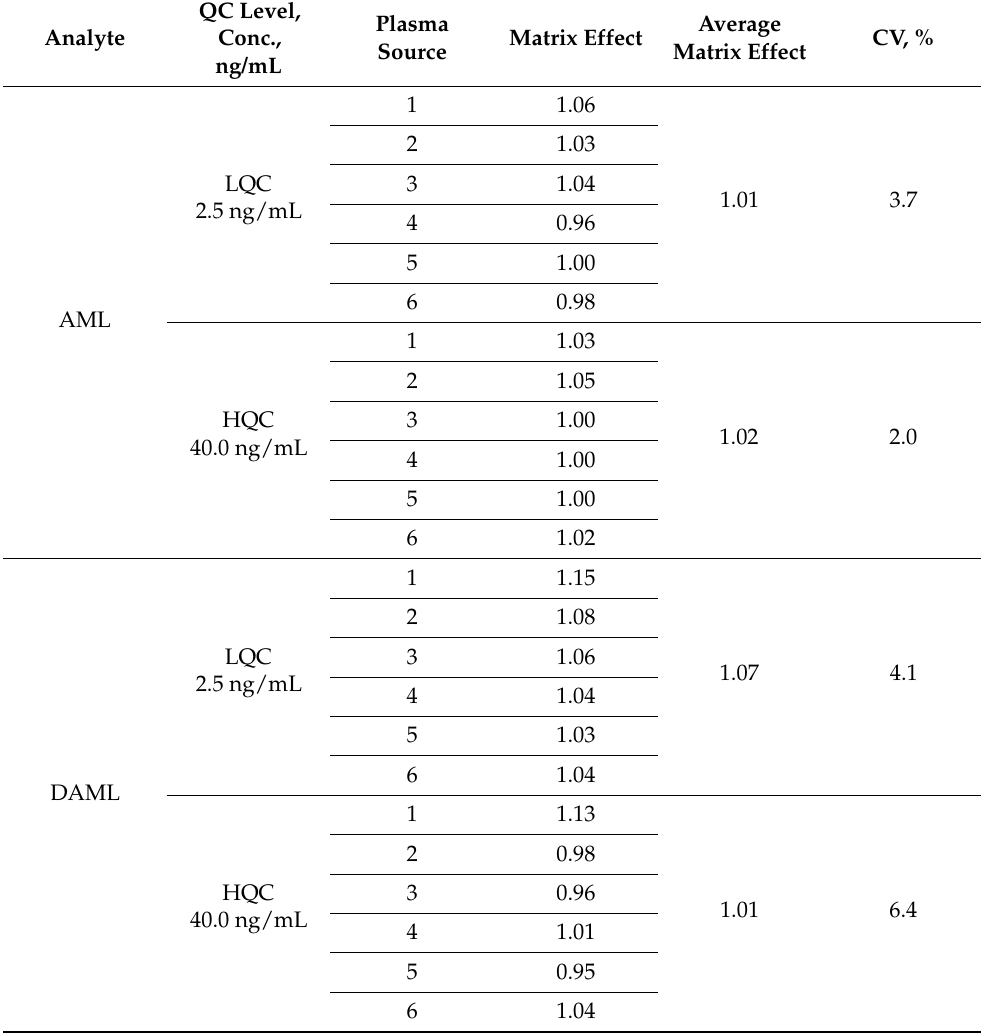
Table A8. Matrix effect for AML and DAML in six human plasma sources. QC Level, Analyte